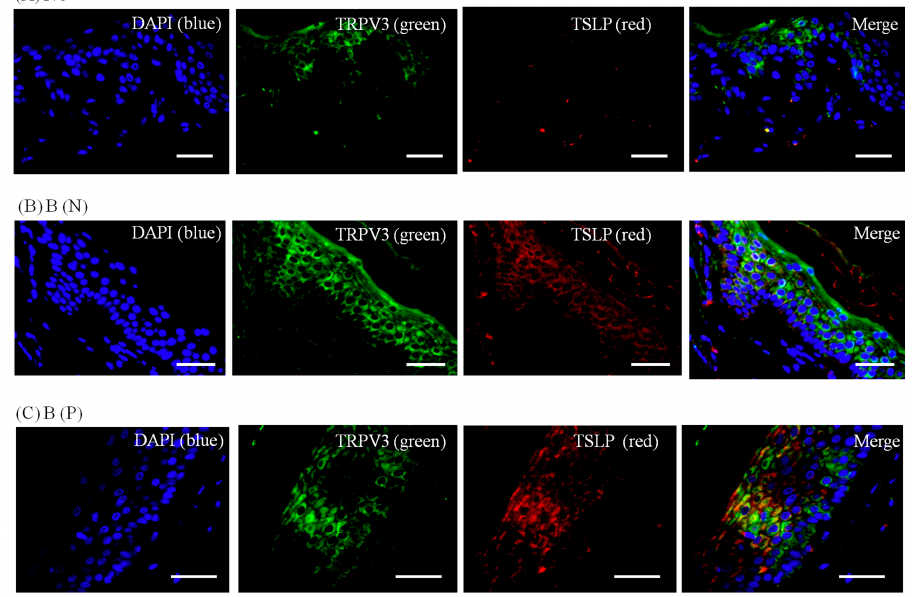
Figure 9. Three-color immuno fl uorescence confocal images were obtained for DAPI ( blue ), TRPV3 ( green ) and TSLP ( red ) from tissues of ( A ) normal, ( B ) nonpruritic and ( C ) pruritic burn scars. The staining of TRPV3 and TSLP, well observed in spinous layer of the epidermis, was least in ( A ) normal control and greater in ( B , C ) burn-scar tissues with or without pruritus. NC: keratinocytes from normal control; B (N): keratinocytes from nonpruritic burn scar; B (P): keratinocytes from pruritic burn scar; TSLP: thymic stromal lymphopoietin. Scale bars = 50 μ m.